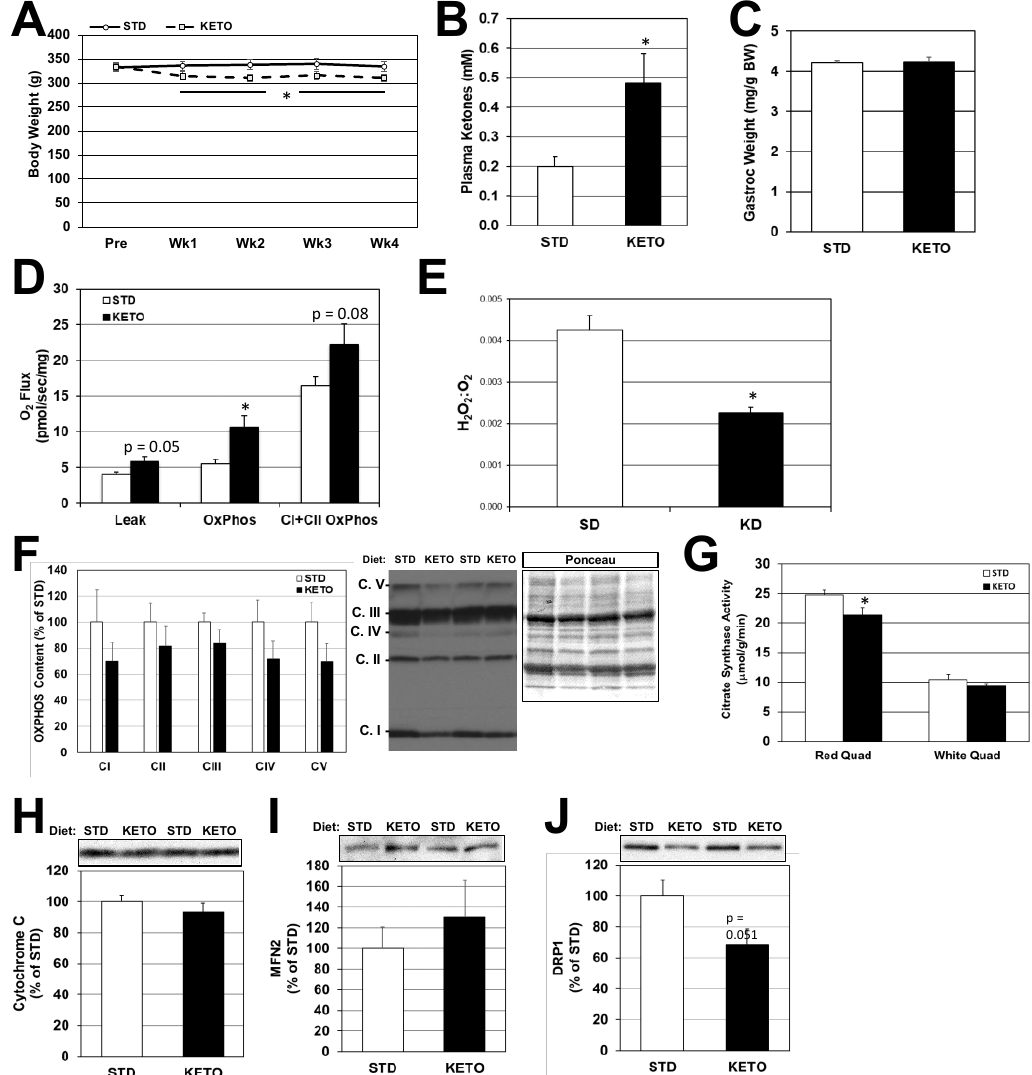
Figure 5. Ketogenic diet induces weight loss and enhances mitochondrial respiration without increased mitochondrial content in skeletal muscle from rats. Fisher 344 rats were pair-fed either a standard (STD) or ketogenic (KETO) diet for 4 weeks. Body weight ( A ) was measured weekly. At the end of the treatment period, blood and skeletal muscle were removed from the rats. Plasma β -hydroxybutyrate ( B ) and gastrocnemius (Gastroc) weight ( C ) were measured. Mitochondrial respiration ( D ) and H 2 O 2 :O 2 ratio ( E ) were determined as in Figure 1. Components of the oxidative phosphorylation system ( F ), citrate synthase activity ( G ) and cytochrome C content ( H ) were measured as markers of mitochondrial content. Protein expression for mitofusin-2 (( I ); MFN2) and dynamin-related peptide-1 (( J ); DRP1) protein expression were assessed as markers of mitochondrial fusion vs. fission. * p < 0.05; n = 6.